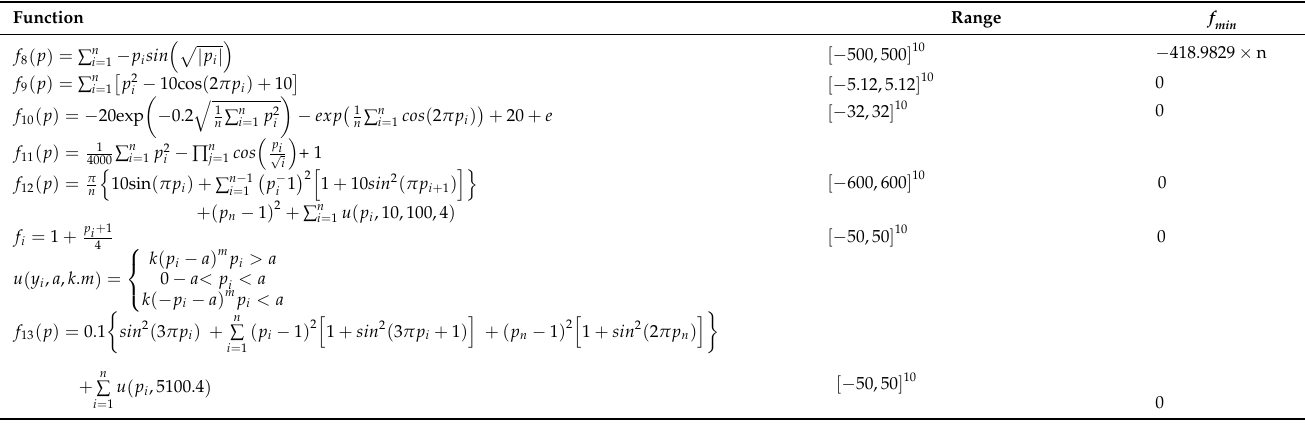
Table 3. Multimodal benchmark functions.